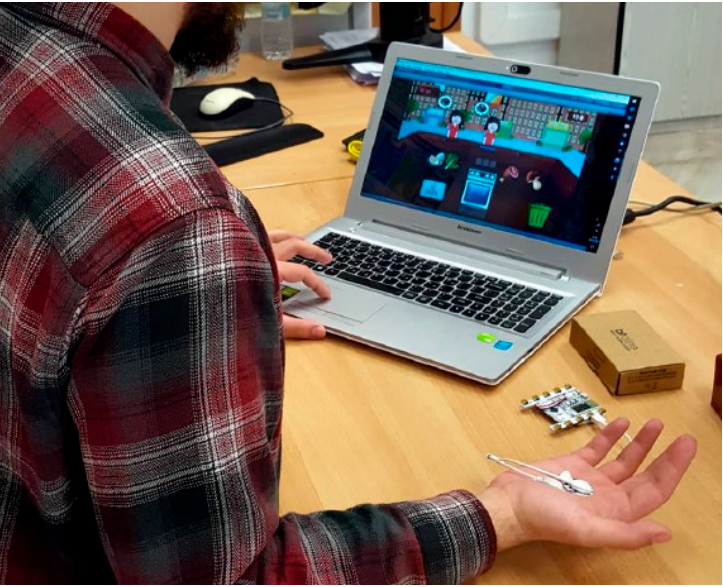
Information 2022 , 13 , x FOR PEER REVIEW Figure 7. User playing the game while using the biofeedback device. Figure 7. User playing the game while using the biofeedback device.